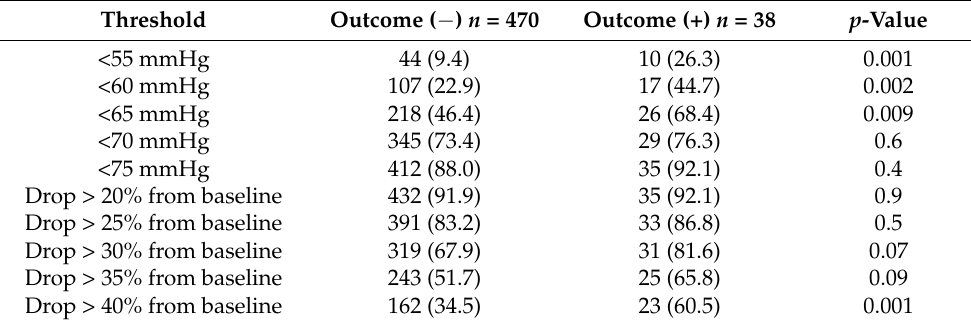
Table 3. Absolute and relative MAP thresholds and their association with the negative